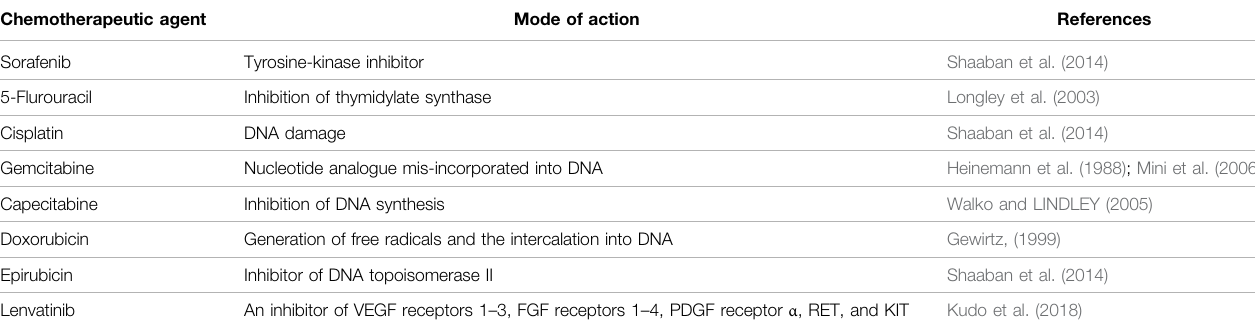
TABLE 2 | Common chemotherapeutic agents in HCC.